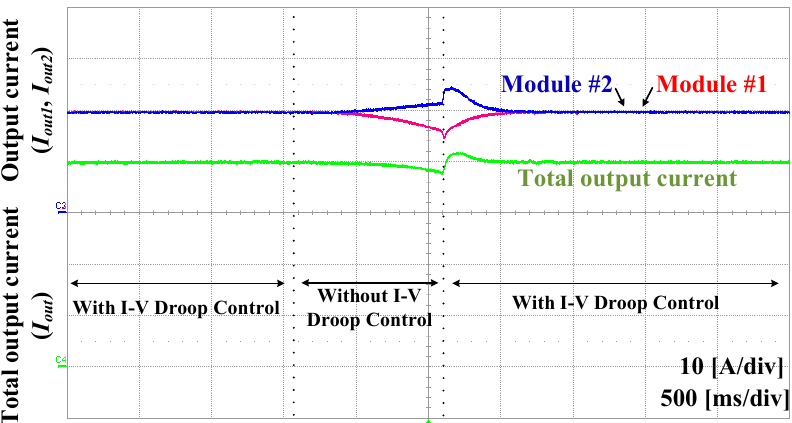
Figure 13. Experimental waveform of the individual and total output current.